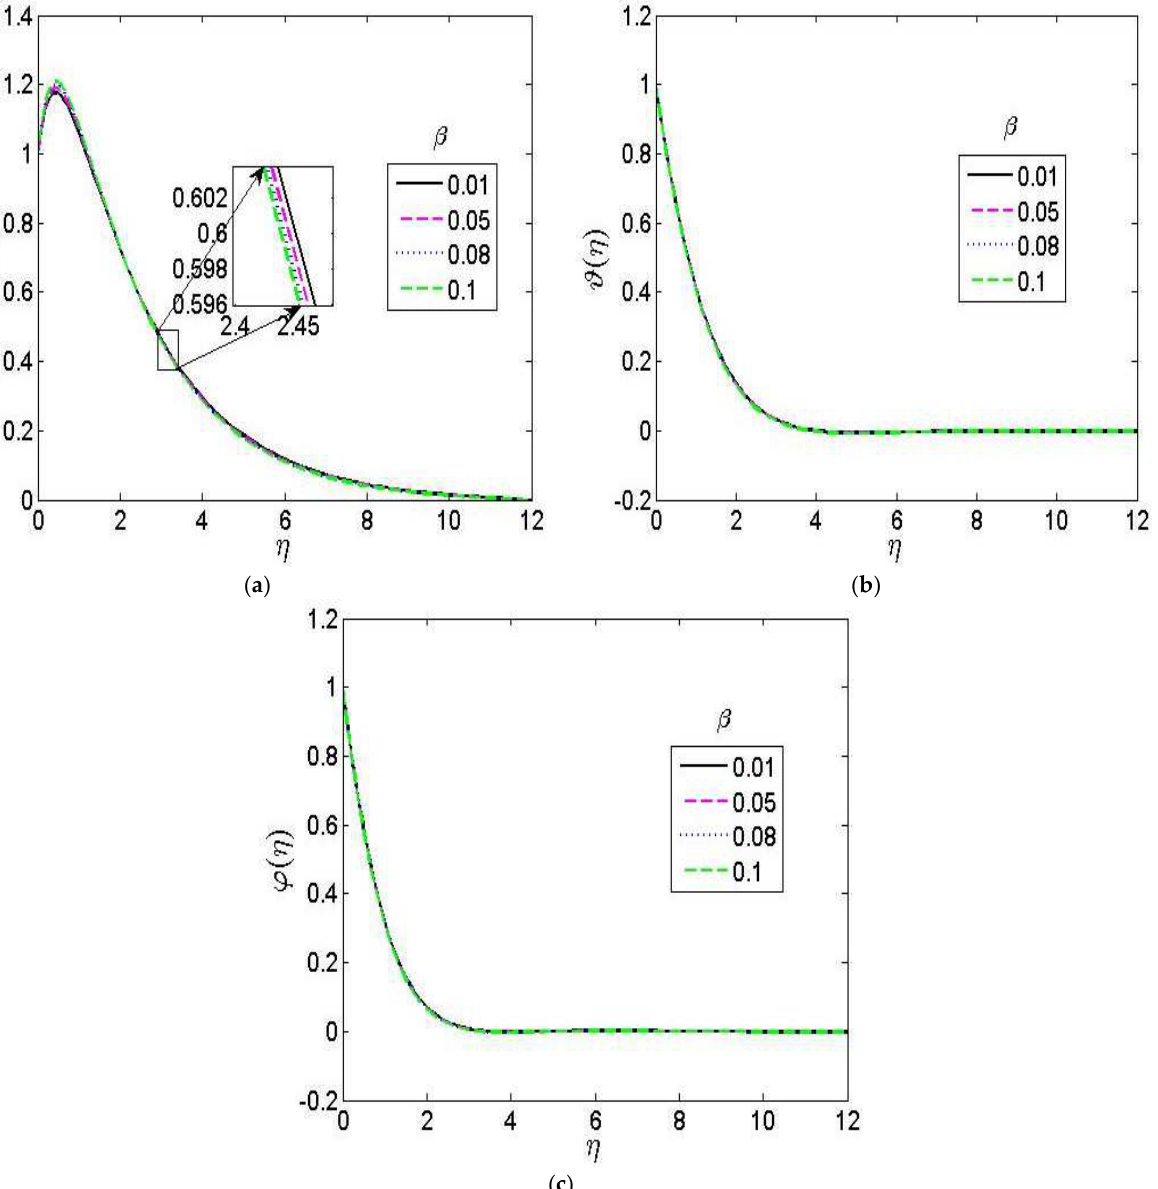
Figure 10. Effect of Weissenberg number β on ( a ) velocity, ( b ) temperature, and ( c ) concentration profiles.